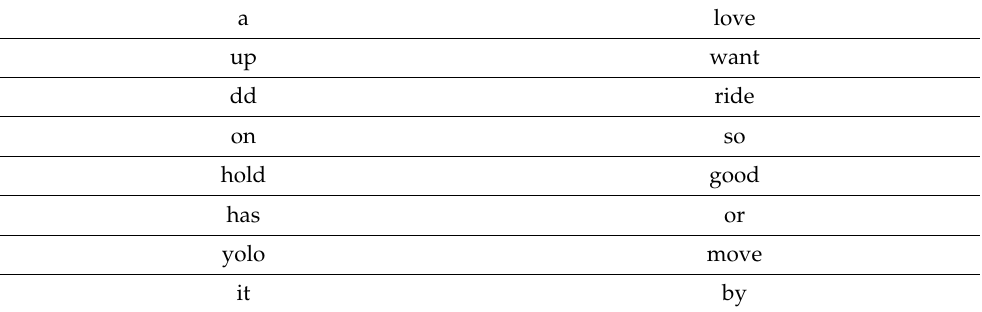
Table A1. Table containing tickers similar to words in the English language, removed from the tickers